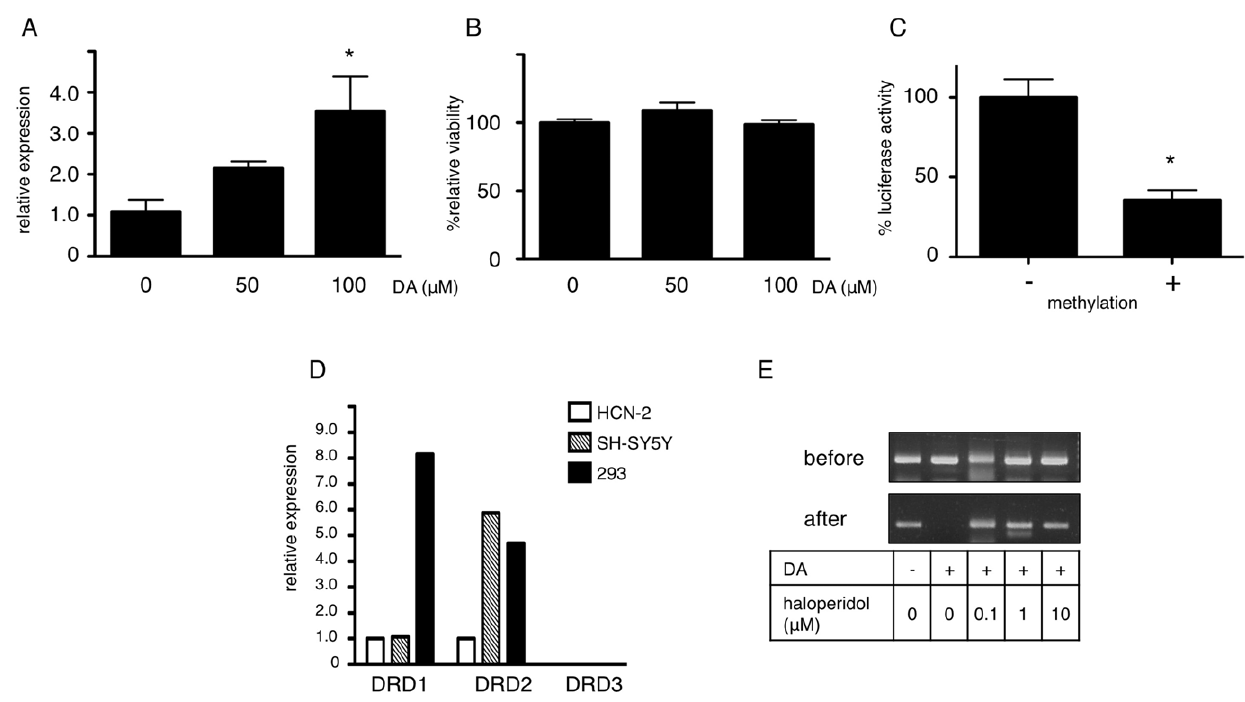
Figure 3. CpG-2 demethylation up-regulates SNCA expression through dopamine receptor signaling. A : Dose dependent up-regulation of alpha-synuclein by dopamine. RNA was extracted from cells treated with the indicated dopamine concentration for 48 h and quantitative PCR was performed. The relative amount of alpha-synuclein mRNA against beta-actin was normalized to dopamine=0. * P , 0.05 vs. DA=0. B : Dopamine does not affect cell viability. MTS assay was performed after addition of dopamine for 48 h. P=0.1559 with ANOVA. C : Methylation of CpG-2 suppresses downstream gene expression. Luciferase assays were performed after transfection of a CpG-free firefly luciferase vector harboring the CpG-2 region at the 5 9 of the luciferase gene. The vector was treated with ( + ) or without (-) CpG methyltransferase prior to transfection. Sea pansy luciferase was co- transfected as an internal control. Relative luciferase activity was calculated by dividing firefly luciferase activity by sea pansy luciferase activity and normalized to methylation ( 2 ) as 100%. Bars indicate standard error. * P=0.0025. D : 293 cells express D1 and D2 dopamine receptors. Expression of DRD1, 2 2 and 2 3 were analyzed in HCN-2, SH-SY5Y, and 293 cells by quantitative RT-PCR. Relative amounts of each receptor are normalized to HCN- 2=1. E : A D2 receptor antagonist ameliorates the demethylation effect of dopamine. Dopamine (DA)- and haloperidol-treated 293 cells were lysed and methylated CpGs were enriched by MBD2 protein. Methylated CpG-2 was detected by PCR before and after enrichment.